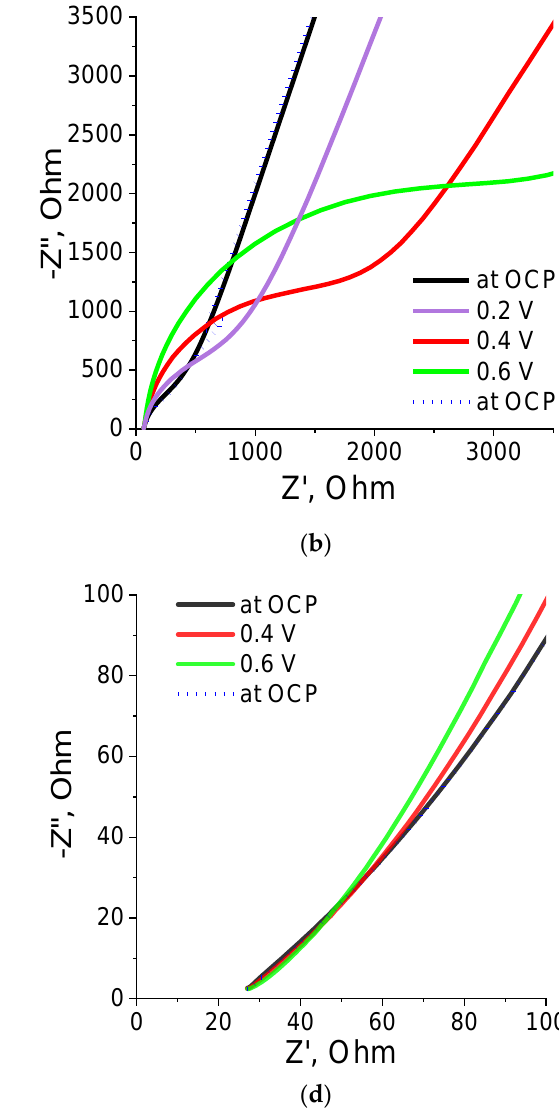
Figure 7. EIS spectra and their enlarged part in the high-frequency region for the P(SBMA-HEMA)@PEDOT ( a , b ) and P(SBMA-VA)@PEDOT ( c , d ) complexes.